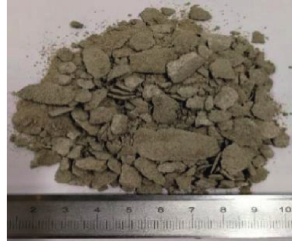
Figure 23: Novel PDC bit.